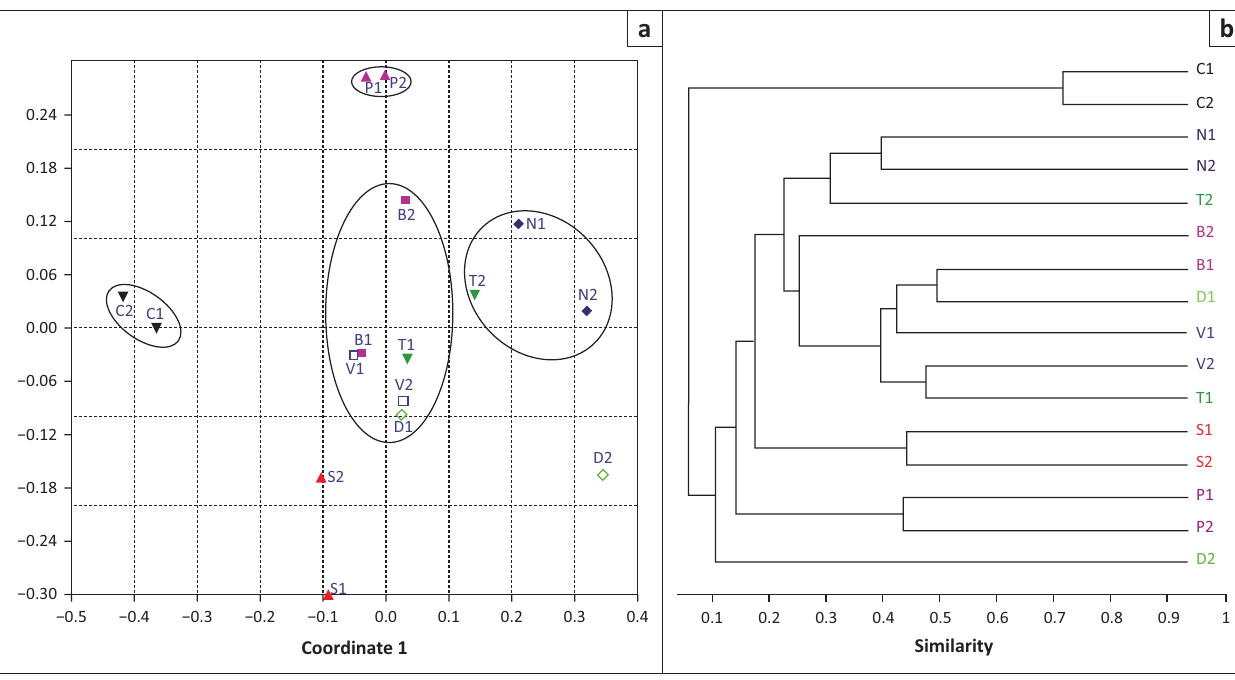
TABLE 4: Post hoc p -values calculated from permutational multivariate analysis of variance analysis of spider assemblages associated with eight habitats in the Amanzi Private Game Reserve. Habitat B